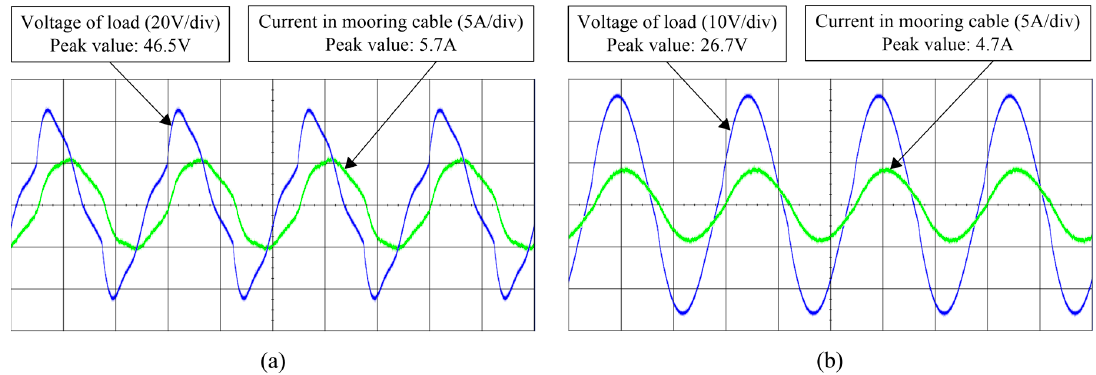
Figure 19. ( a ) Waveforms in the condition of a maximum power load; ( b ) Waveforms in the condition of maximum efficiency.